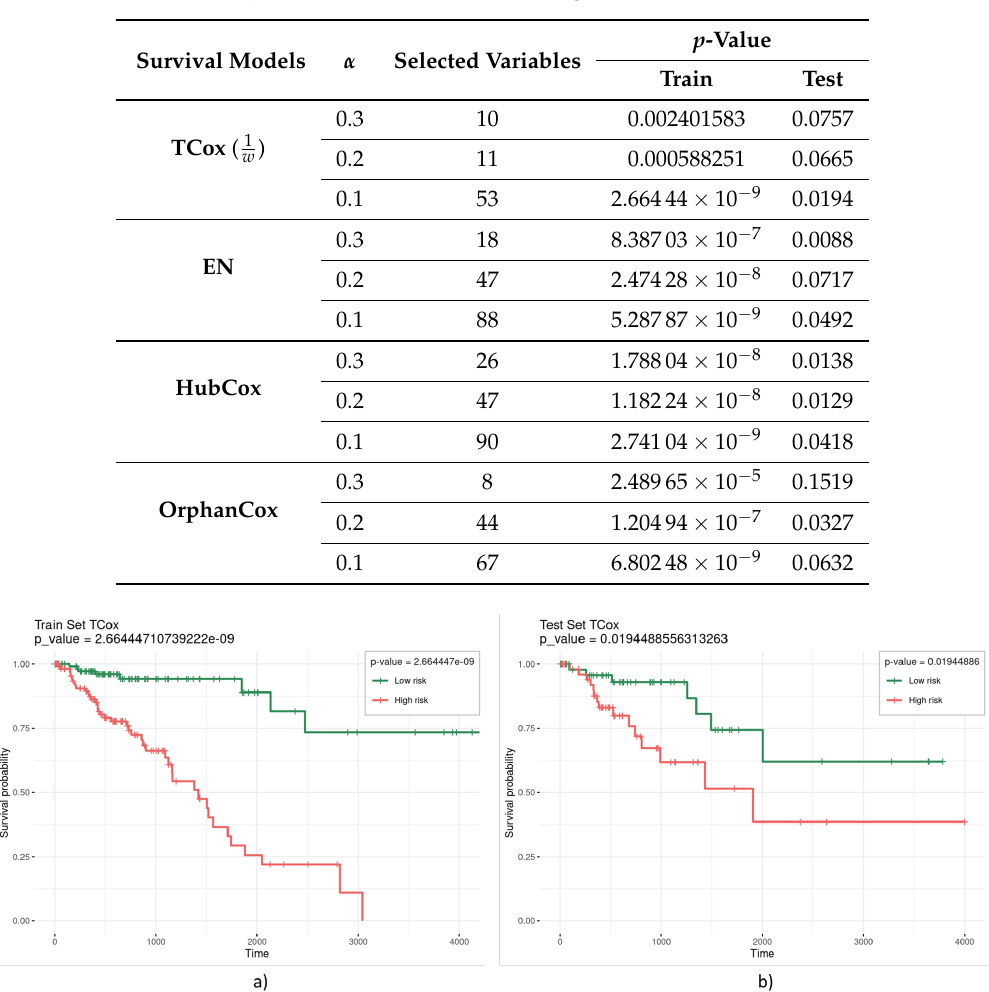
Figure 3. Kaplan–Meier curves obtained from the ( a ) training and ( b ) test sets, based on the variables selected by the TCox model with α =